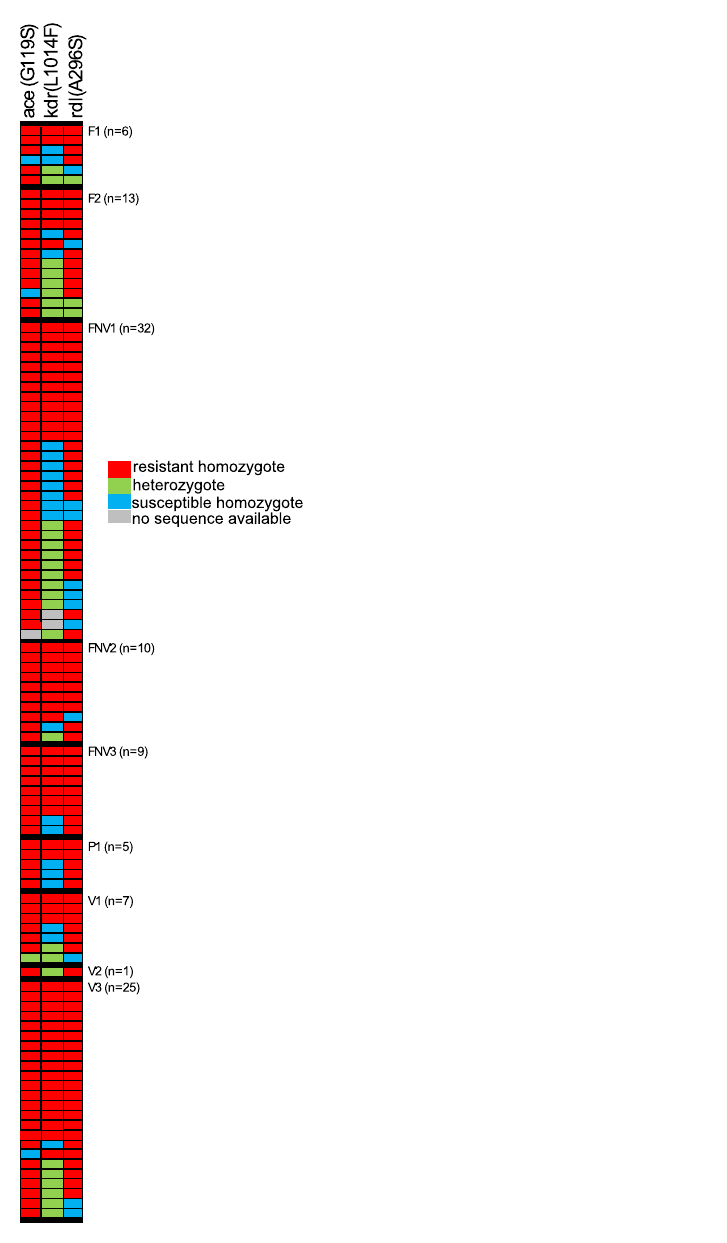
Figure 6. Insecticide resistance mutations are very frequent in Anopheles peditaeniatus . All A. peditaeniatus (n = 108) in the molecularly typed set of 844 are depicted here sorted by their collection location and within collection site by their insecticide resistance genotypes. Each row of three boxes represents genotype data from a single A. peditaeniatus individual. Out of 108 A. peditaeniatus , 106 carried the G119S mutation (3 heterozygotes, 103 homozygotes), 78 carried the L1014F mutation (22 heterozygotes, 56 homozygotes), and 104 carried the A296S mutation (12 heterozygotes, 92 homozygotes). Forty nine percent (53/108) of individuals have homozygous resistant genotypes for all 3 loci and an additional 23% (25/108) carry at least one resistant allele for each of the 3 insecticide loci typed. Of the remaining 28% of individuals (30/108), 28 carried the homozygous susceptible allele at the L1014F kdr mutation (2 individuals with no available sequence), 17 were homozygous for the resistant allele at both ace-1 and rdl , another 7 individuals were homozygous for ace G119S and heterozygous for rdl A296S. A single individual was homozygous for the rdl resistant mutation and heterozygous for the ace-1 mutation. Five individuals carried a resistance mutation at only one of the 3 loci tested, 3 were ace-1 mutation homozygotes, 1 was heterozygous for rdl resistance and 1 was homozygous for rdl resistance with no sequence available for ace-1